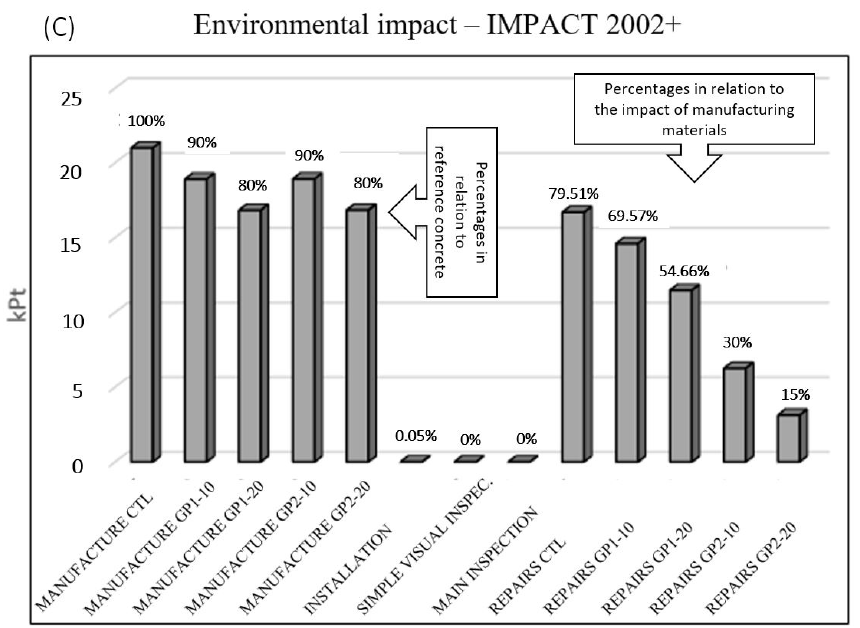
Figure 18. ( a ) Total GWP in 100 years; ( b ) embodied energy in 100 years; ( c ) total impact in 100 years. Figure 18. ( A ) Total GWP in 100 years; ( B ) embodied energy in 100 years; ( C ) total impact in 100 years.